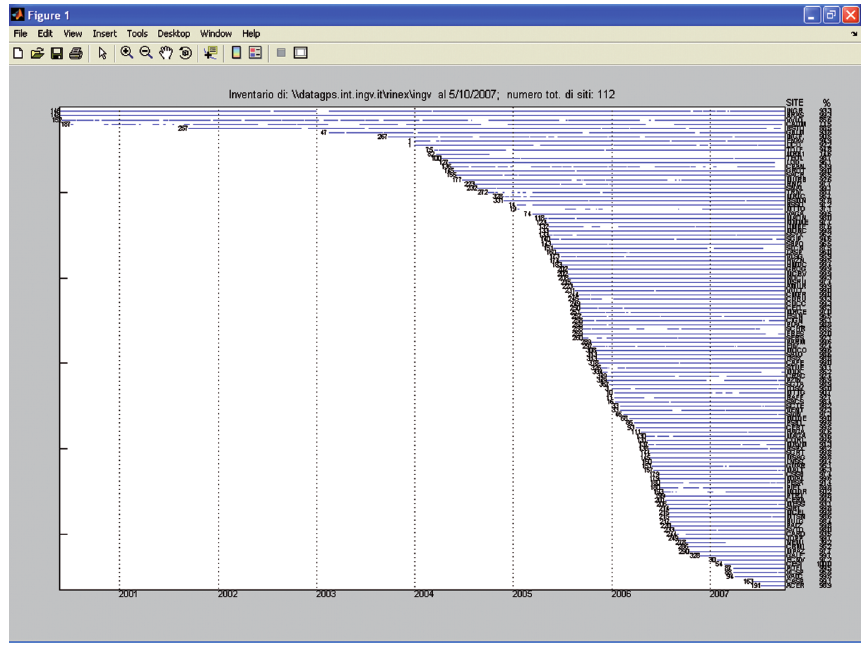
Fig. 4. Temporal evolution and data inventory for the single stations of the RING network. A sharp increase of the CGPS stations starts since 2004 (courtesy of Dr. R.